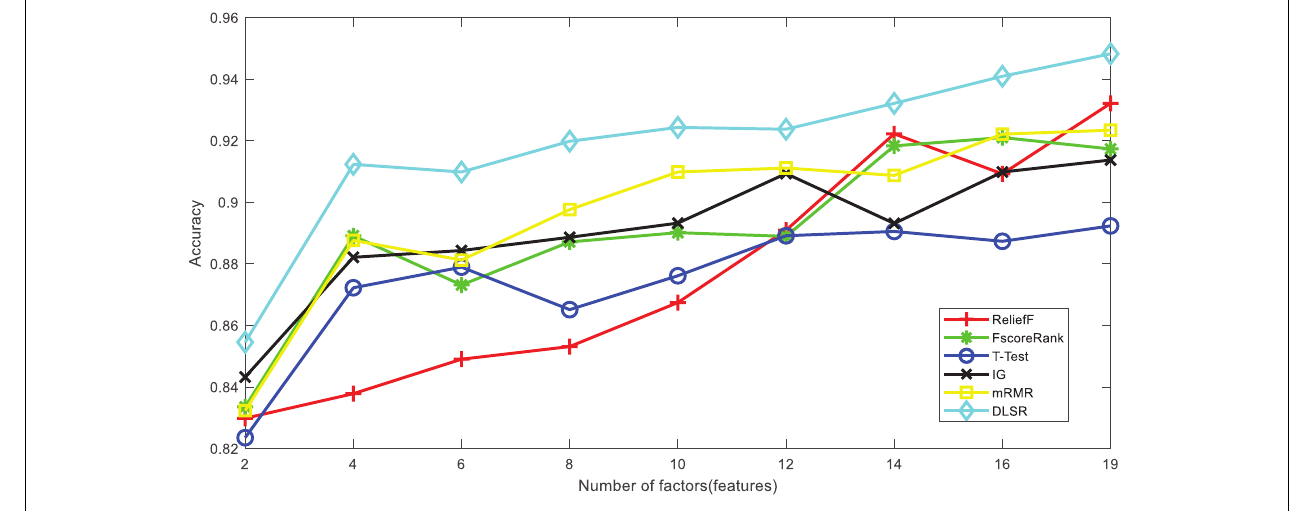
FIGURE 2 | Performance of accuracy against number of enterprise social responsibility factors.